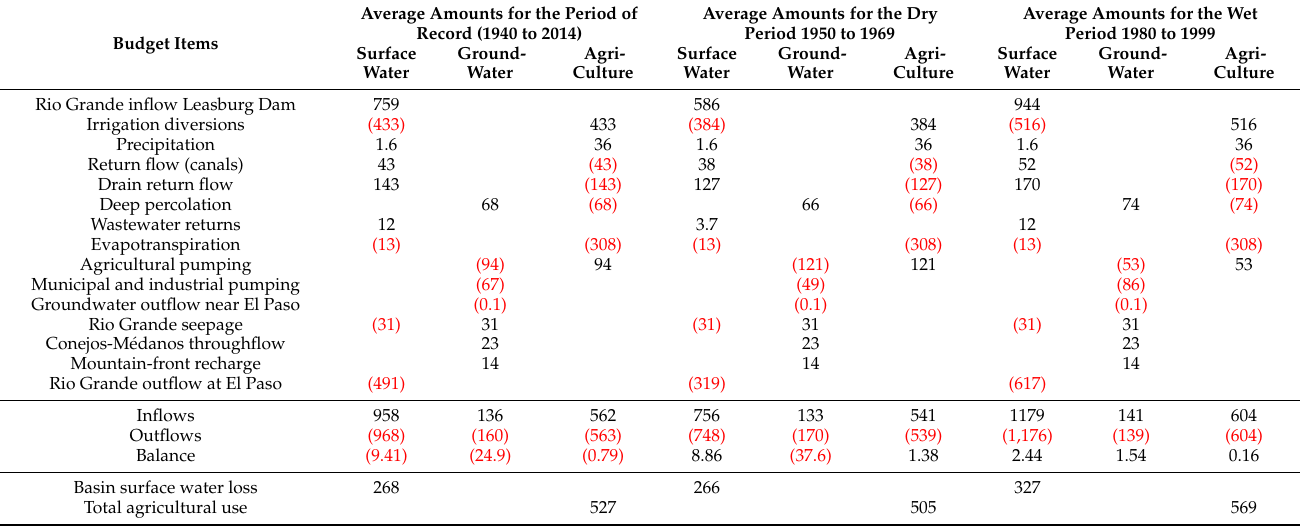
Table 2. Water-budget components (in cubic hectometers) and the sum of inflows and outflows for the Mesilla portion of the Basin for three time periods. Parentheses and red font used in the table for negative